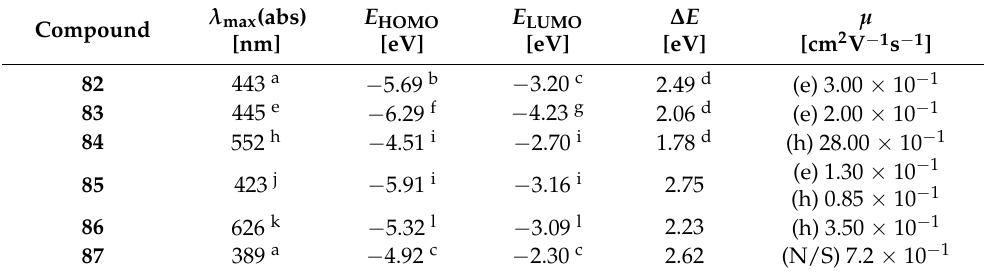
Table 8. Electronic and optical properties of semiconductors 82 – 87 .